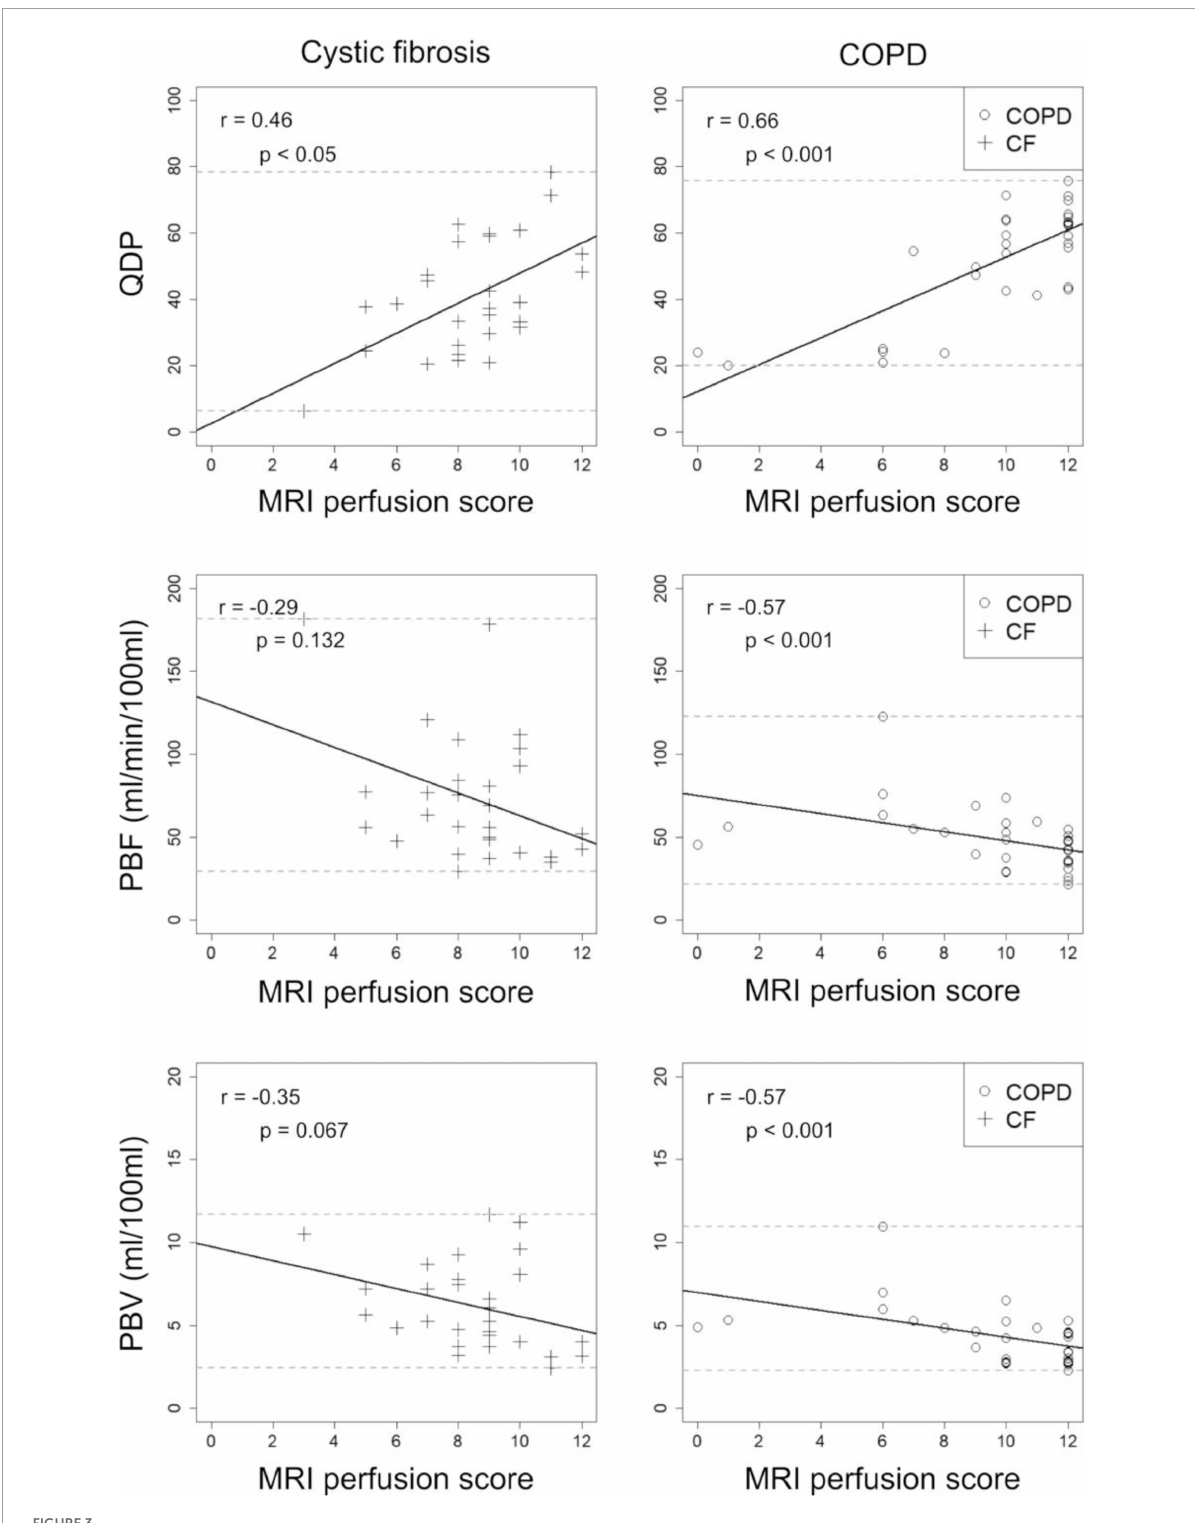
FIGURE3 Correlations between perfusion defects in percent (QDP), pulmonary blood flow (PBF), and pulmonary blood volume (PBV) with the visual MRI perfusion score in 13 cystic fibrosis (CF, crosses) and 14 chronic obstructive pulmonary disease (COPD, circles) patients. MRI1 and MRI2 were combined. Spearman’s r correlation coefficients and corresponding p -values are given in each panel. Solid lines indicate the linear regression, dashed lines the minimum and maximum observed value for the parameter on the